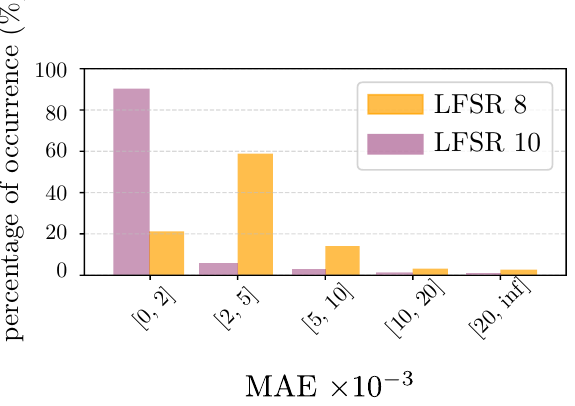
Figure 6. MAE histogram for the 8-bit and 10-bit LFSR examples. The Absolute Errors (AE) for different seed indexes when varying x and y are pre- sented in Figure 7. The worst case (Figure 7a) occurs when we generate the y BS with seed index 0, producing maximum correlation between both input BSs. As seen, the maxi- mum error is produced around the center, when the variance of the signal is maximum ( x = y = 0.5), taking maximum error values of up to 0.25. The second plot (Figure 7b), shows the error behaviour for the first resonant peak of Figure 5 (seed index 25). On this occasion, the maximum error is spotted when one of the signals is 0.5 and the other is at 0.25 and 0.75, raising error values of up to 0.12, almost half of the worst case. The best seed (index = 97) is presented in Figure 7c, where the maximum error rises to no more than 0.011, an order of magnitude less than the first resonant peak. Finally, the further seed index (idx = 127) is shown in Figure 7d. As can be seen, its behavior is very similar to the best seed index case (Figure 7c), presenting a maximum value of 0.016; 0.005 higher than the best seed case. As shown, the outcome pattern varies depending on the seed employed; the seeding effect is therefore a major concern when utilizing LFSRs as the random source for generating stochastic